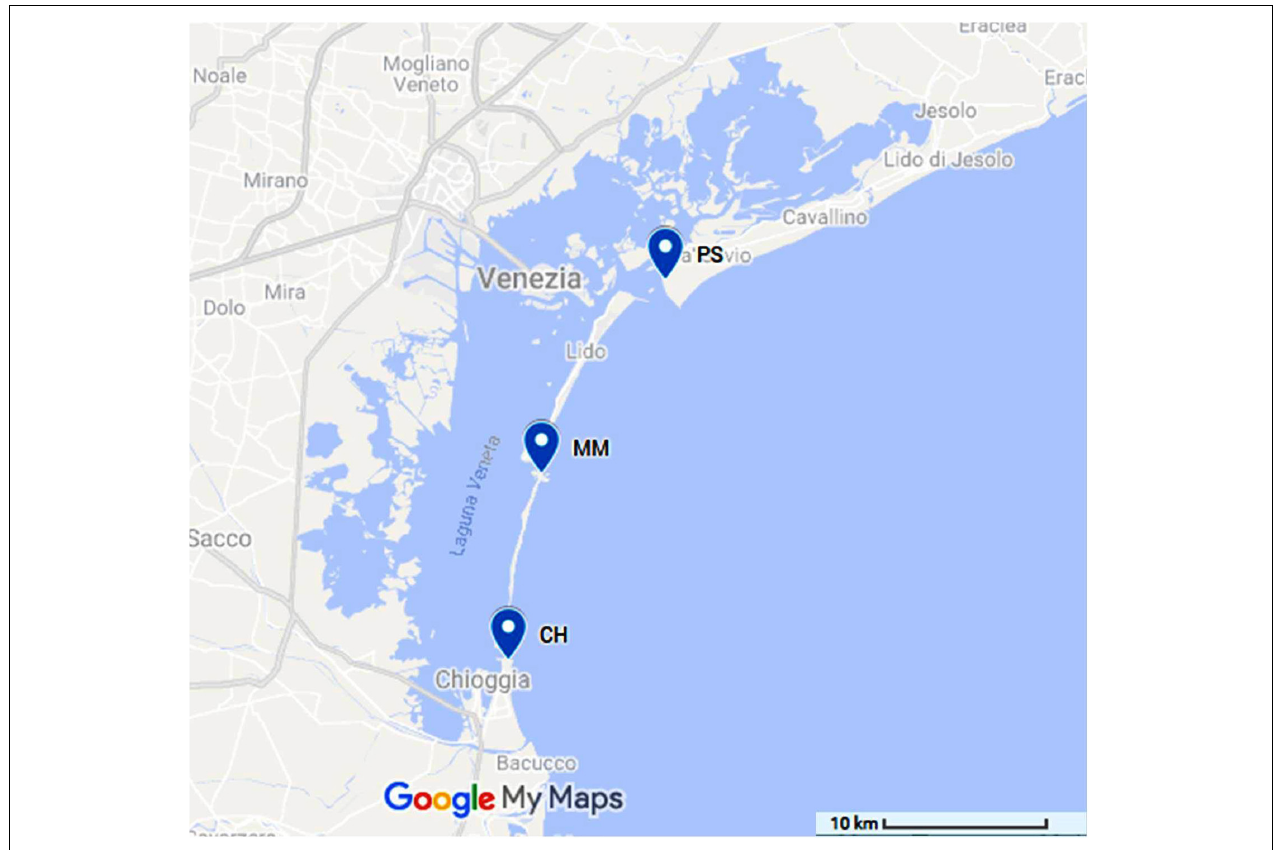
FIGURE 1 | Location of the sampling